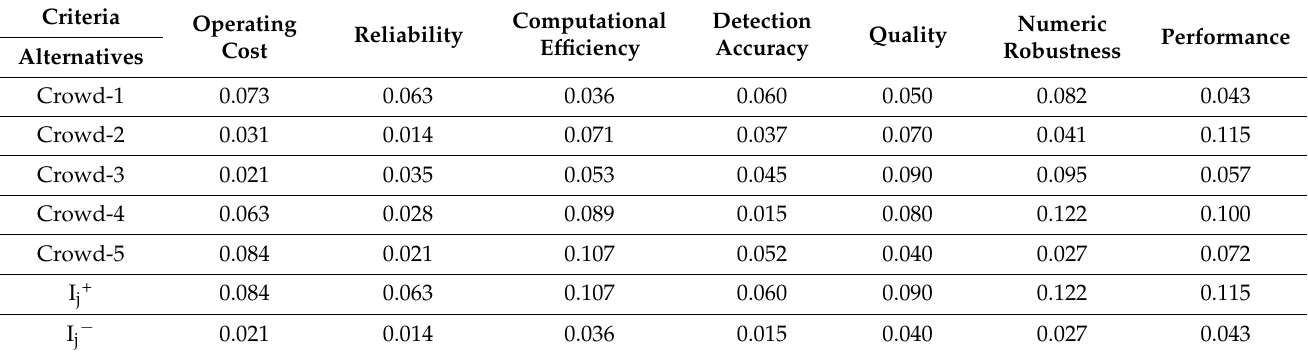
Table 9. Beneficial and non-beneficial parameter